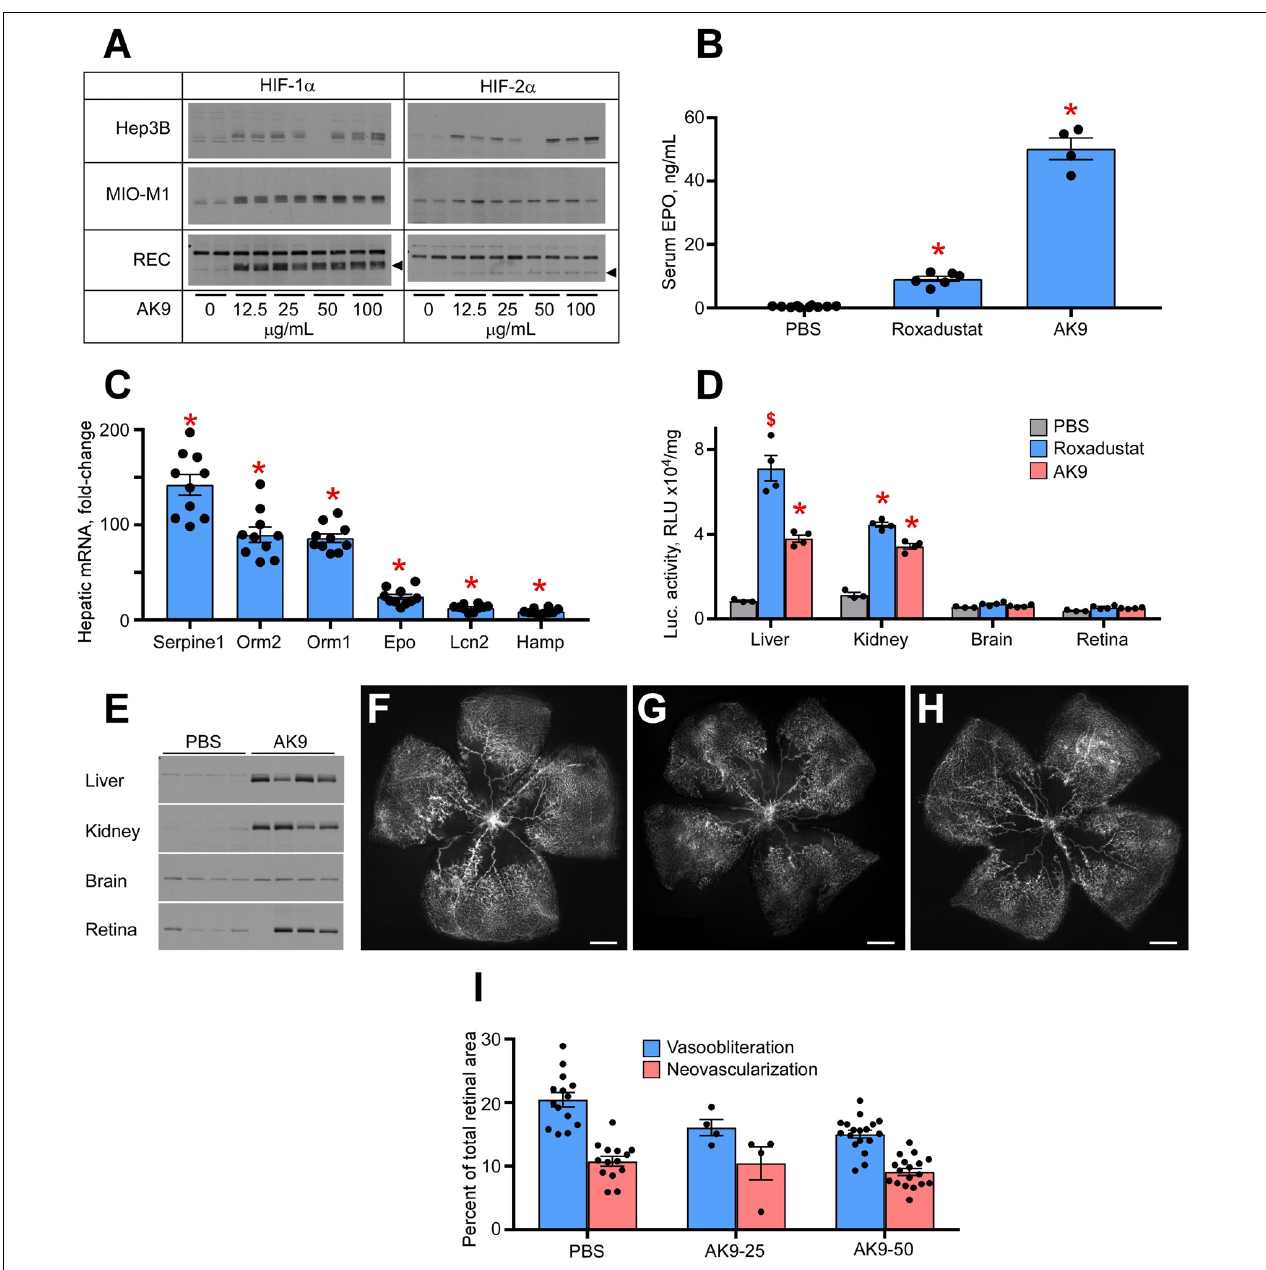
FIGURE 1 | Potency of AK9 in HIF stabilization and prevention of OIR. (A) Western blot analysis of HIF-1 α /2 α protein levels in three types of cultured cells treated overnight with the indicated concentrations of AK9. (B) Levels of serum Epo obtained from blood of P8 pups 6 h after a single intraperitoneal injection of PBS (control), 10 µ g/g Roxadustat or 50 µ g/g AK9. PBS, n = 10; Roxadustat, n = 6; AK9, n = 4. (C) Hepatic mRNA levels of select genes, known to be upregulated by Roxadustat (Hoppe et al., 2016). P8 mouse pups were administered 50 µ g/g AK9 by intraperitoneal injection, euthanized 6 h later and their livers were dissected for mRNA analysis as described in Methods. Gene expression levels are presented as fold-change vs control (PBS injection = 1), n = 10 for each experimental condition. (D) Luciferase activity in tissue homogenates of P8 Luc-ODD mouse pups 3 h after PBS (control), Roxadustat (10 ( µ g/g) or AK9 (50 µ g/g) injections serving as a reporter of HIF stability. Data expressed as relative light units (RLU) normalized to tissue protein. BS, n = 3; Roxadustat n = 4; AK9, n = 4. (E) Western blot analysis of HIF-1( α protein levels in the organs of P8 mouse pups 3 h after PBS (control) or AK9 (50 µ g/g) injections. (F–H) Representative retinal flatmounts of the control PBS-injected (G) and AK9-treated (H) mouse pups at P17 following hyperoxia exposure from P7 to P12 as detailed in Methods, scale bar = 500 µ m. (I) Quantitative analysis of retinal flatmount images exemplified in panels (G,H) for areas of capillary loss (vasoobliteration) and vascular tufting (neovascularization) tested at two doses of AK9, 25 and 50 µ g/g. PBS, n = 14; AK9-25, n = 4; AK9-50, n = 18. All p values vs PBS were > 0.05. P values are presented as follows, * ≤ 0.0001; $ ≤ 0.005; & ≤ 0.01; # ≤ 0.05, and represent statistical difference vs PBS control.